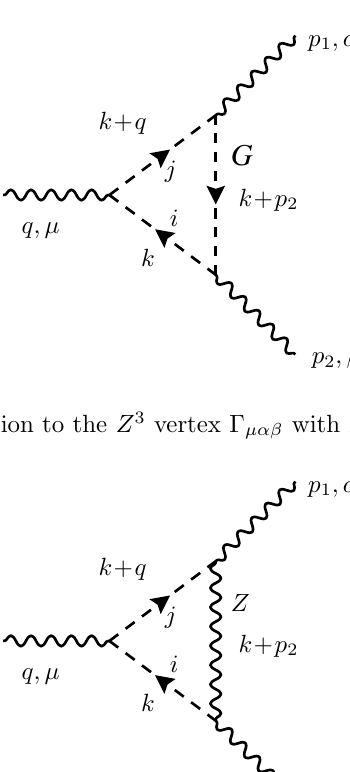
0 in the (cid:22)(cid:11)(cid:12) with h i ; h j ; Z